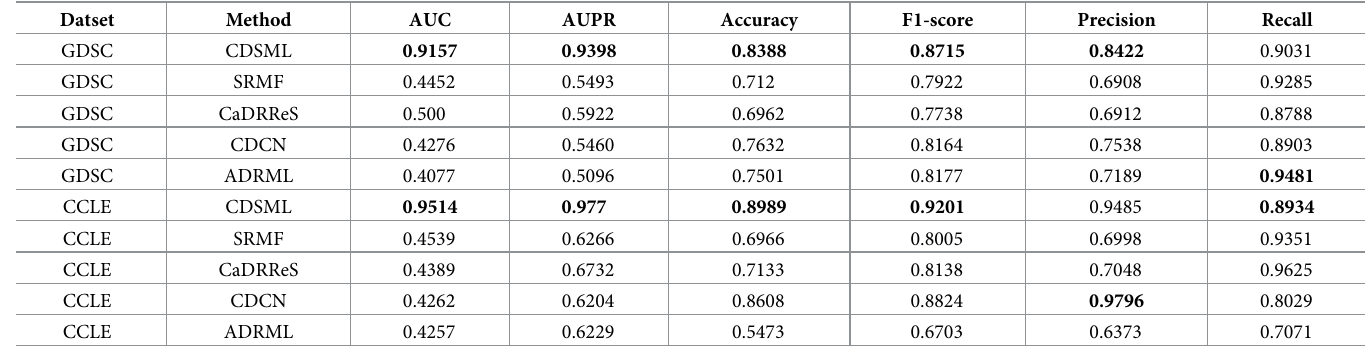
Table 9. Comparison of CDSML’s performance with state-of-the-art regression methods’ performance on GDSC and CCLE. The assessments were done by averaging 30 repetitions of stratified five-fold cross-validation. The highest value of each criterion is shown in